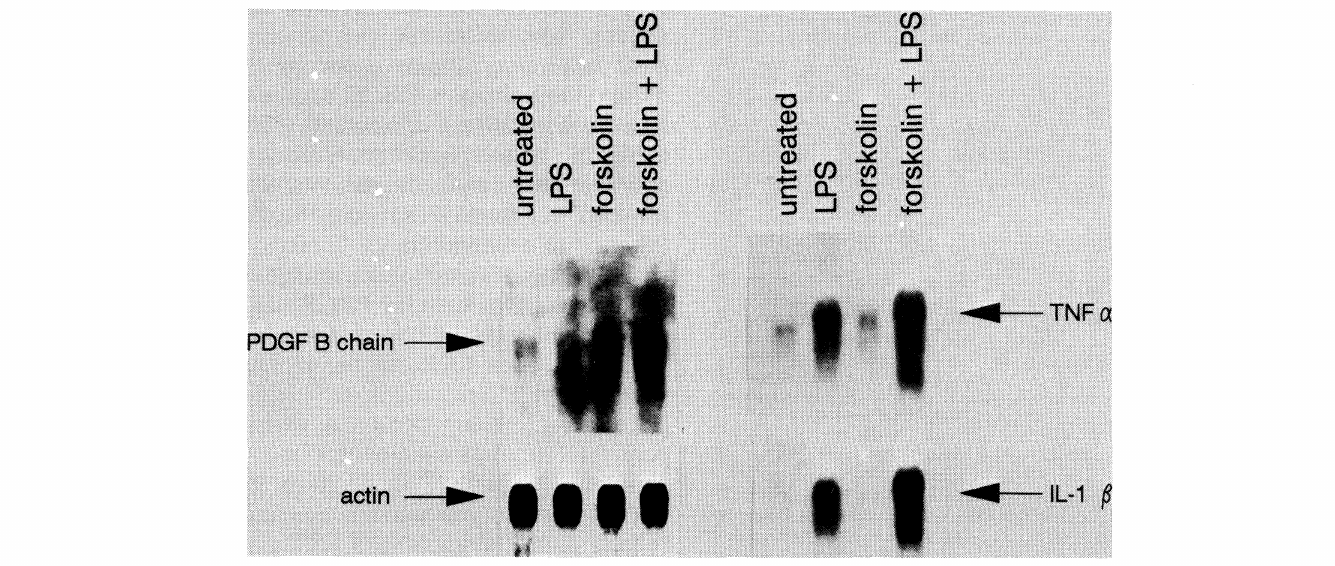
FIG. 2. Differential expression of cytokine genes in response to treatment with LPS and forskolin. ANA-1 cells were cultured for 4h with or without LPS (1 Ig/ml) and forskolin (10 IM). Northern blots were sequentially hybridized with the indicated cDNA probes.